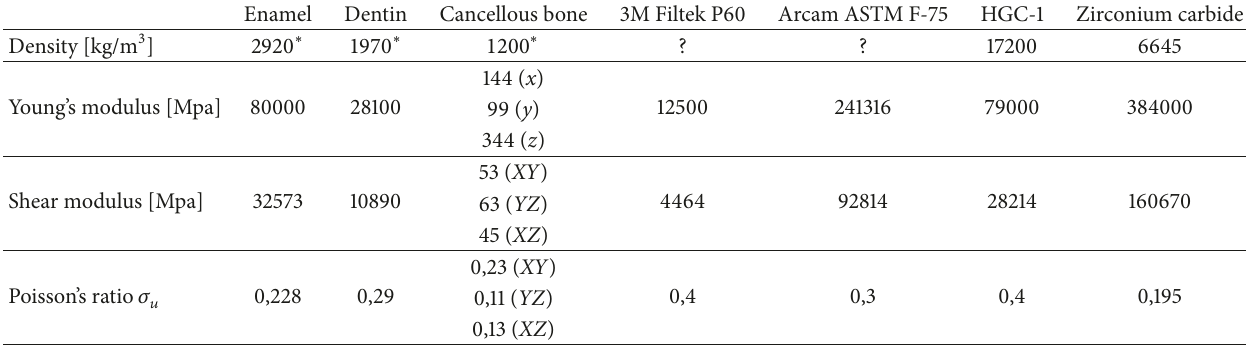
Table 1: Density of the material involved in the